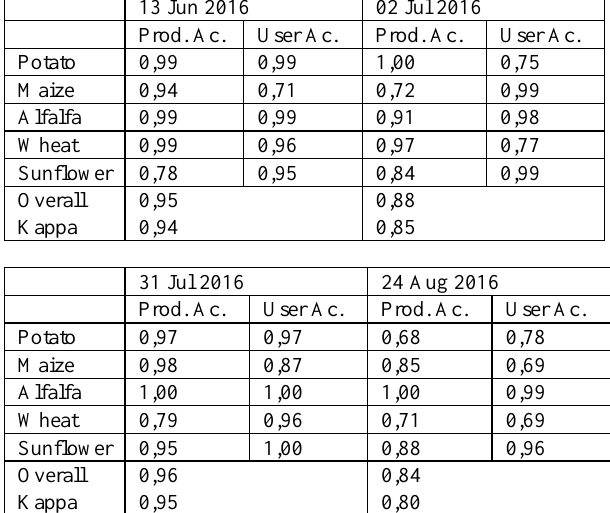
Table 4. Accuracy assessment of land use maps.